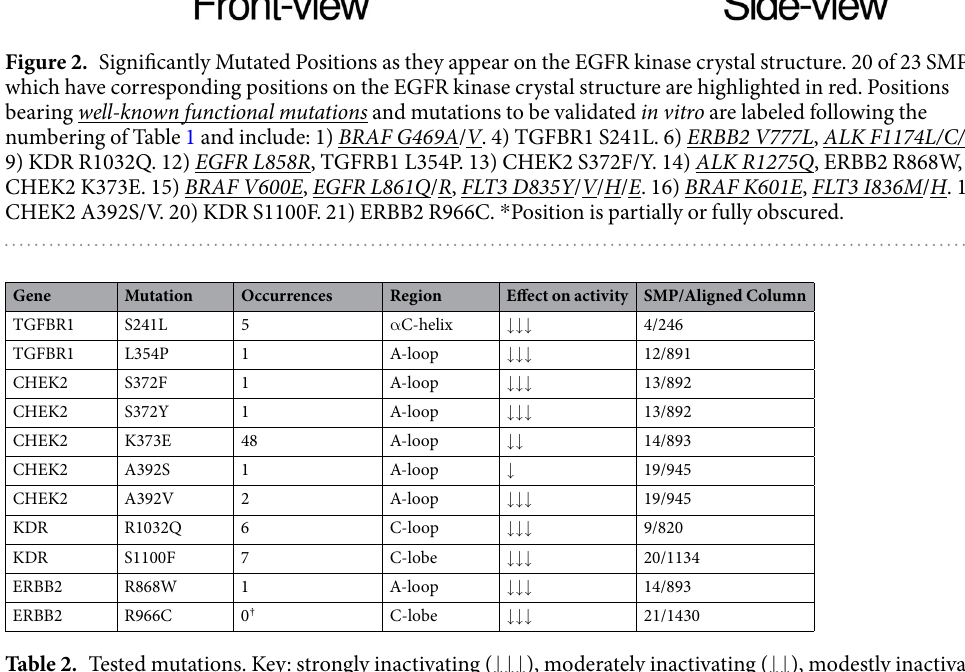
Table 2. Tested mutations. Key: strongly inactivating ( ↓↓↓ ), moderately inactivating ( ↓↓ ), modestly inactivating ( ↓ ). † ERBB2 R966C was not directly observed in the dataset, but this amino acid substitution is common at this SMP in other genes (see